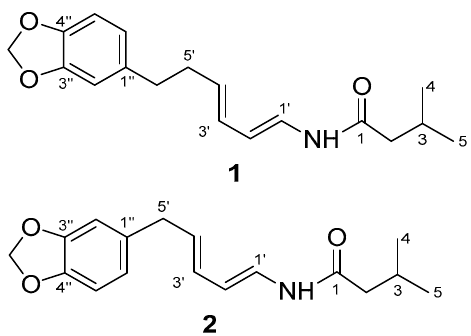
Figure 2. Structures of piperenamide A-B (1-2) .